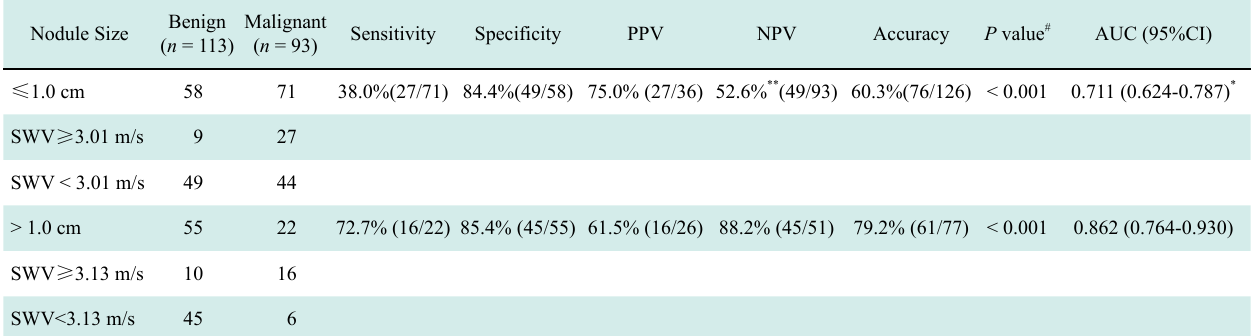
Table 4 Predictive performance of SWV median value for differentiating malignant from benign thyroid nodules in terms of different nodule sizes Benign Malignant Nodule Size ( n = 113) ( n = 93)